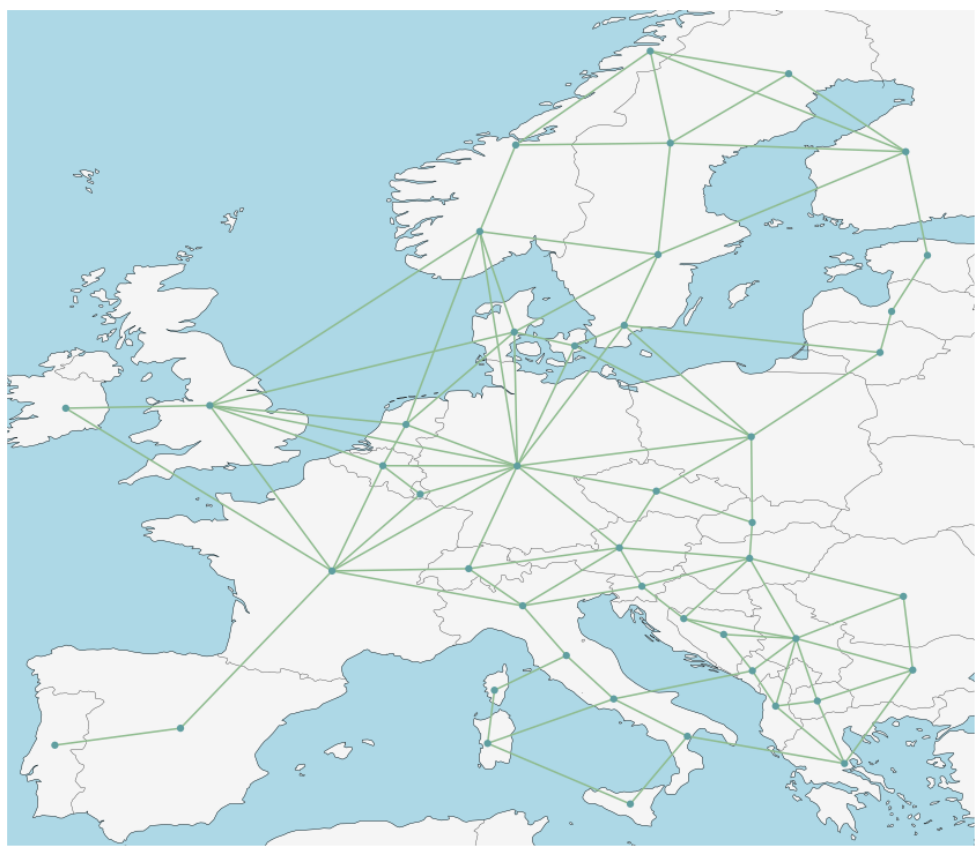
Figure 3. Zonal network consisting of 45 zones obtained using PyPSA-Eur